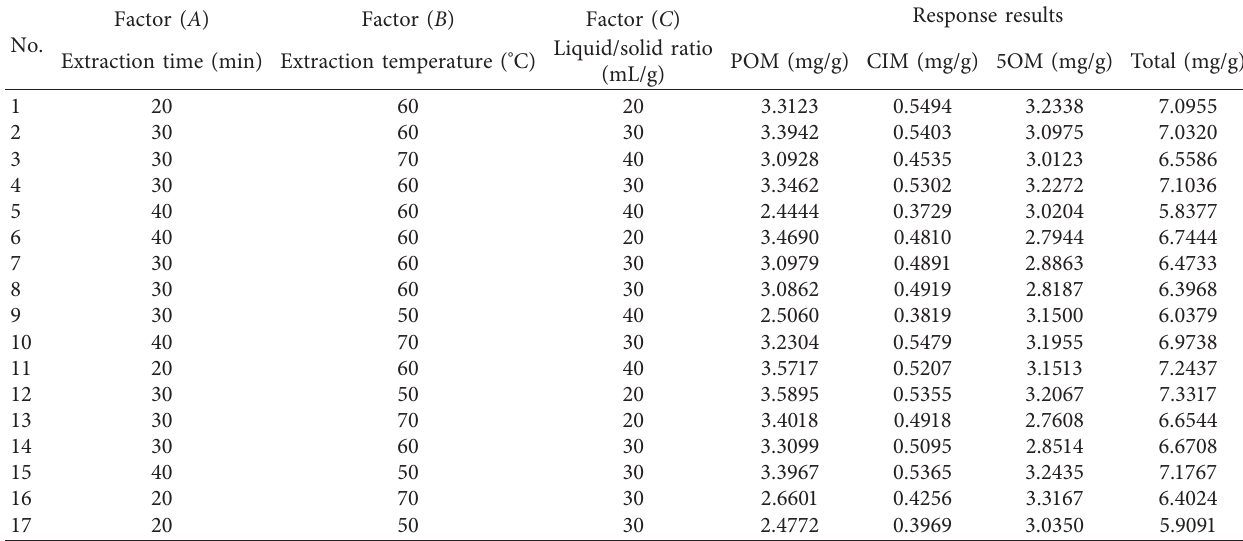
Table 2: Design and results of response surface experiment.